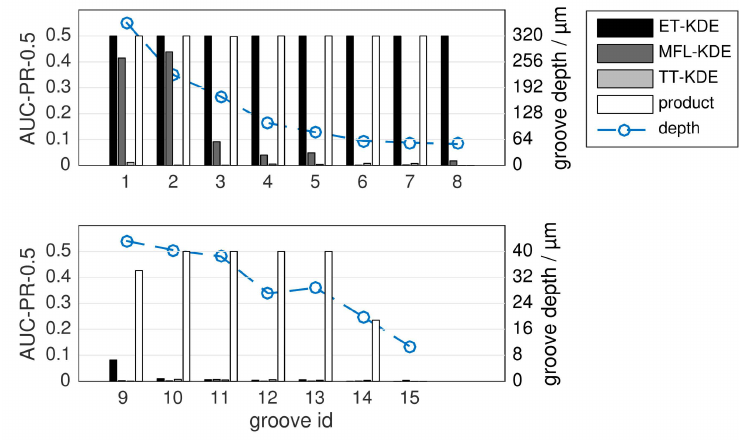
Figure 11. Evaluation of single-sensor detection (ET-KDE, MFL-KDE, TT-KDE) versus fusion, for the product fusion rule and a fixed kernel size. The maximum possible score is 0.5 (left vertical axis). The set of grooves is divided into two sub-figures for clarity. Groove depth is indicated by the blue line corresponding to the right vertical axis. Note the different axis scales for groove depth in the two